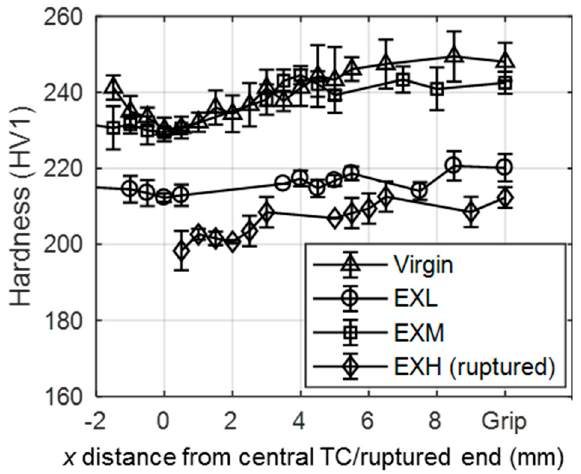
Figure 6. Variation of hardness with distance from the central thermocouple for the virgin, EXL, and EXM material, and with distance from the ruptured end of the EXH material.